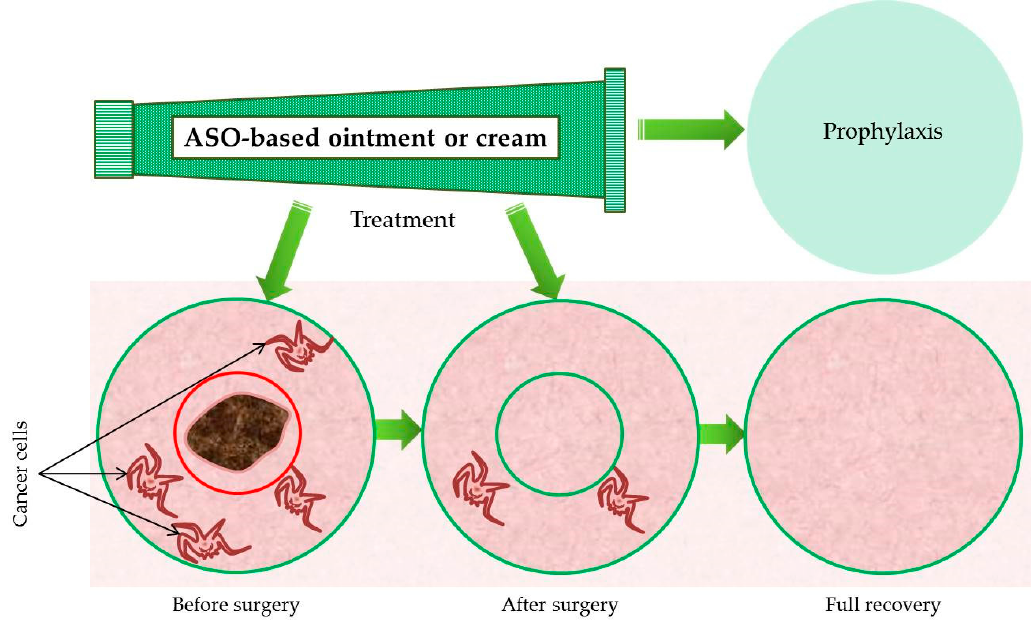
Figure 7. Methods of applying a cream or ointment based on antisense oligonucleotides in the treatment of melanoma.